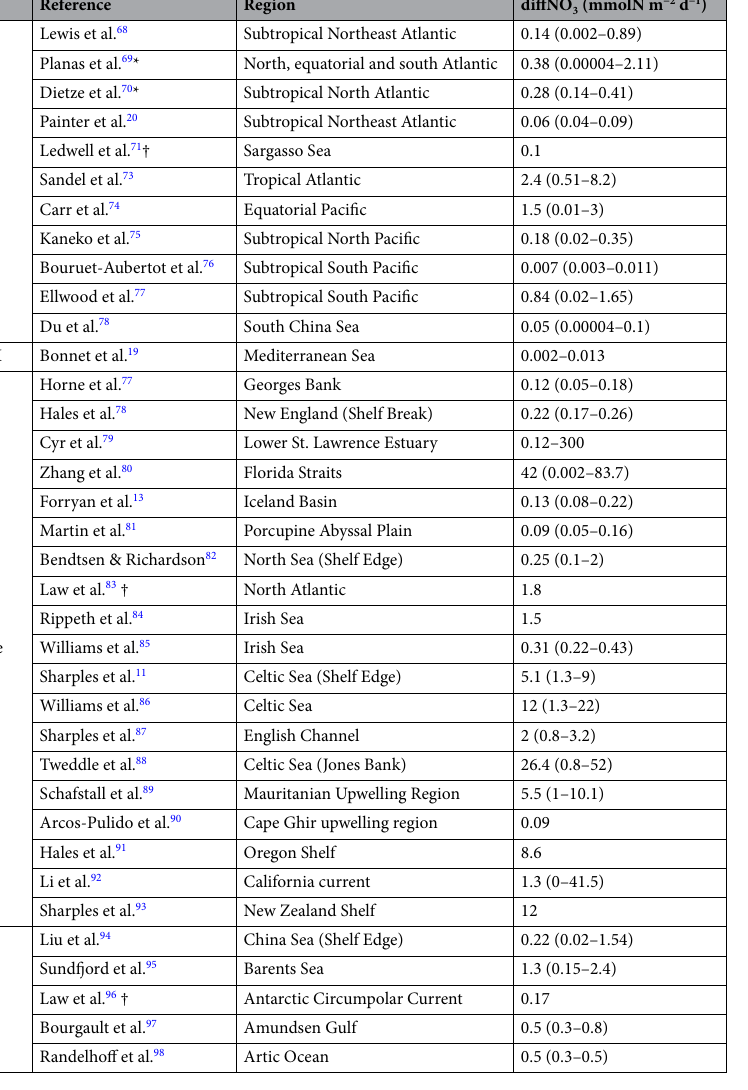
Table 5. Compilation of nitrate diffusive fluxes. Nitrate diffusive fluxes previously reported in the literature in several domains (D): tropical and subtropical regions (T) (40º N – 40ºS), Mediterranean Sea (M), shelf seas and upwelling regions (Te), and Polar regions (P). The mean (and the range, between brackets) of estimates reported at each study are indicated. When the mean was not provided this value was calculated considering the published range. Publications reporting the dataset included in this analysis are not listed. When several frontiers for the calculation were used, the nitracline was choose. A molar mass of 62 gmol −1 was used for converting nitrate concentration from mg to mmol used in some of the references listed. * indicates estimates derived from acoustic Doppler and † from tracer release